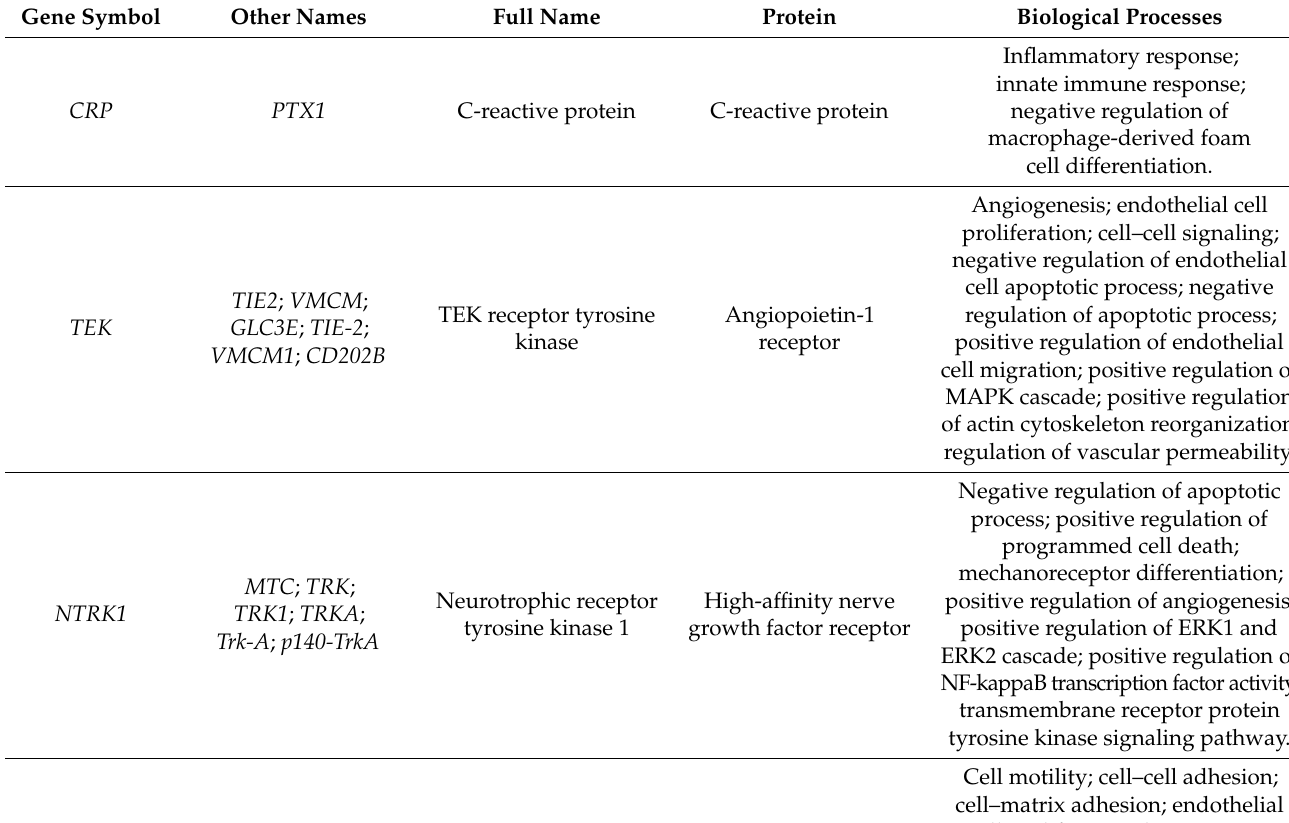
Table 1. Functional roles and general information of the down-regulated hub